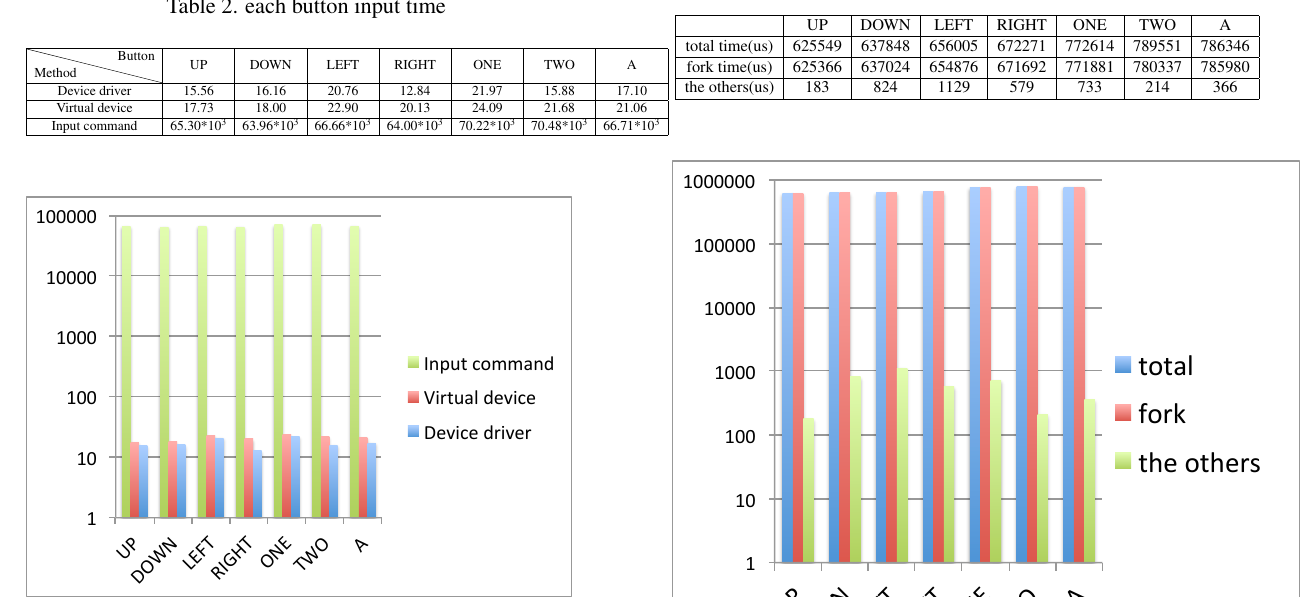
Table 3. each total processing time and fork time of the input command version